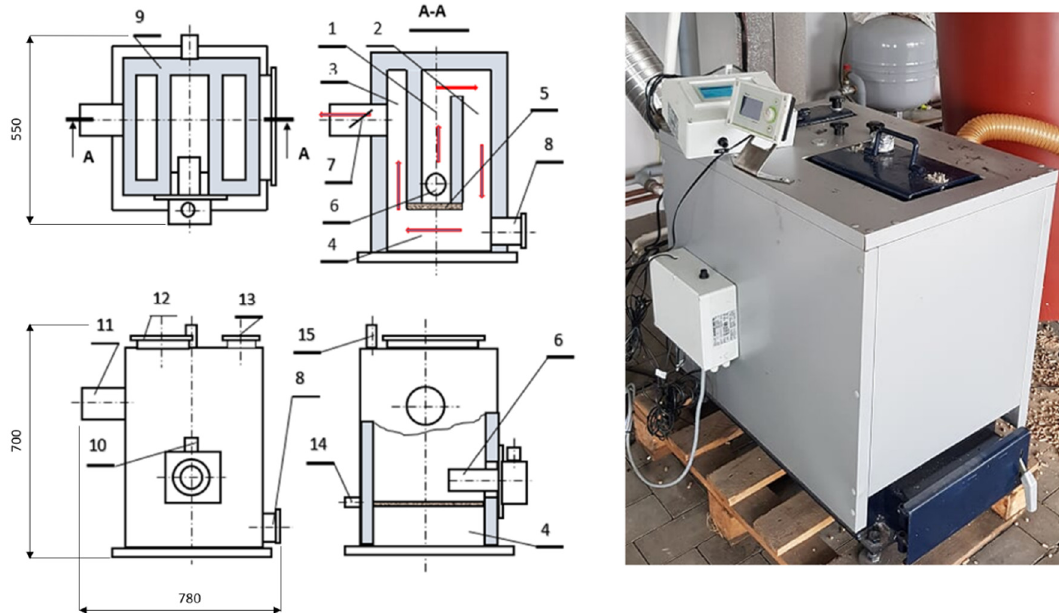
Figure 12. View of the boiler with 10 kW flue gas circulation: 1—combustion chamber, 2—convection chamber I, 3—convection chamber II, 4—combustion gas circulation chamber, 5—airtight sliding grate closing the combustion chamber, 6–10 kW retort burner, 7—thrust adjustment slide, 8—ash removal cleaning duct, 9—water jacket (flue gas / water heat exchanger), 10—fuel feed (pellet),